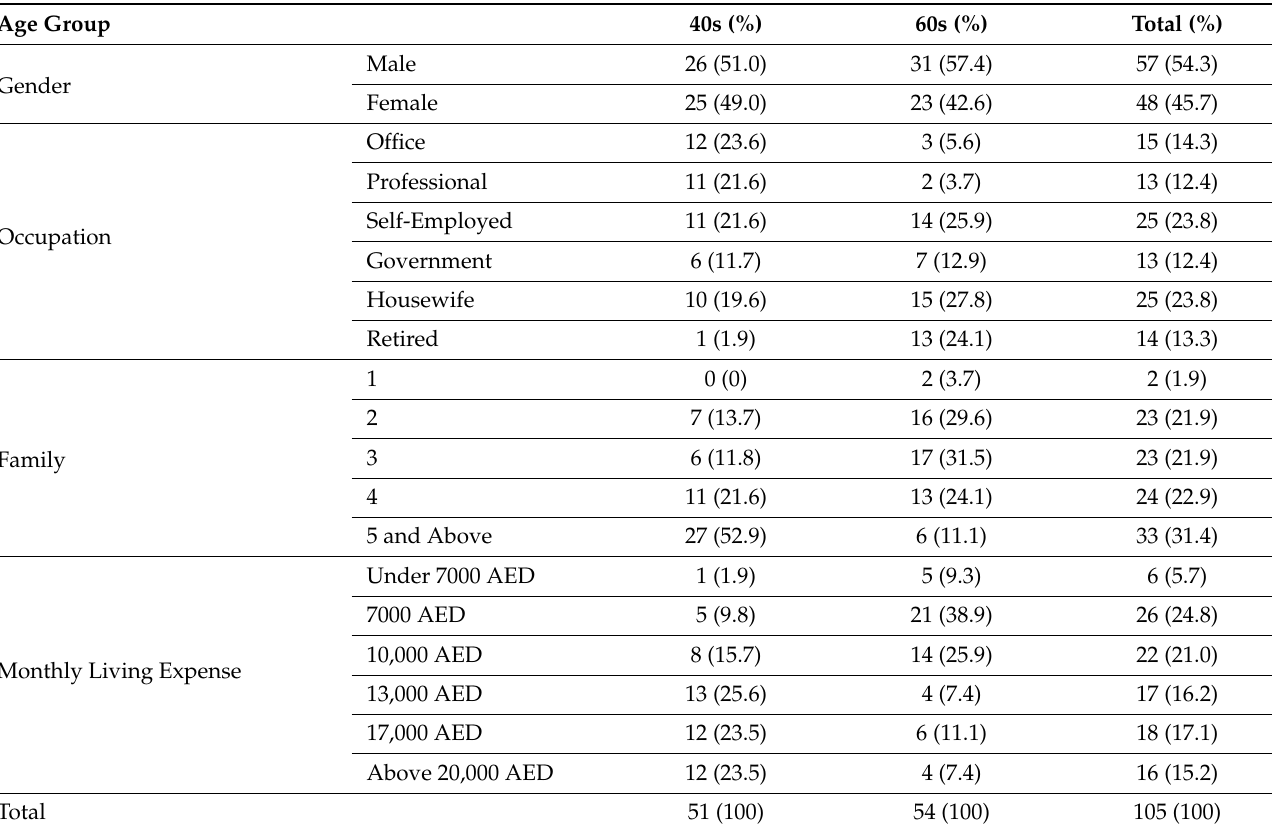
Table 2. Socio-demographic Characteristics of Survey